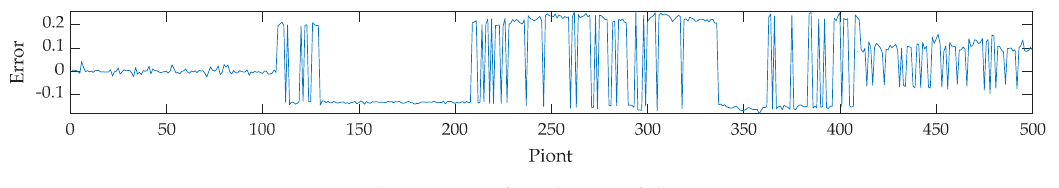
Figure 8. Relative error of prediction of the PSO-RGVP.